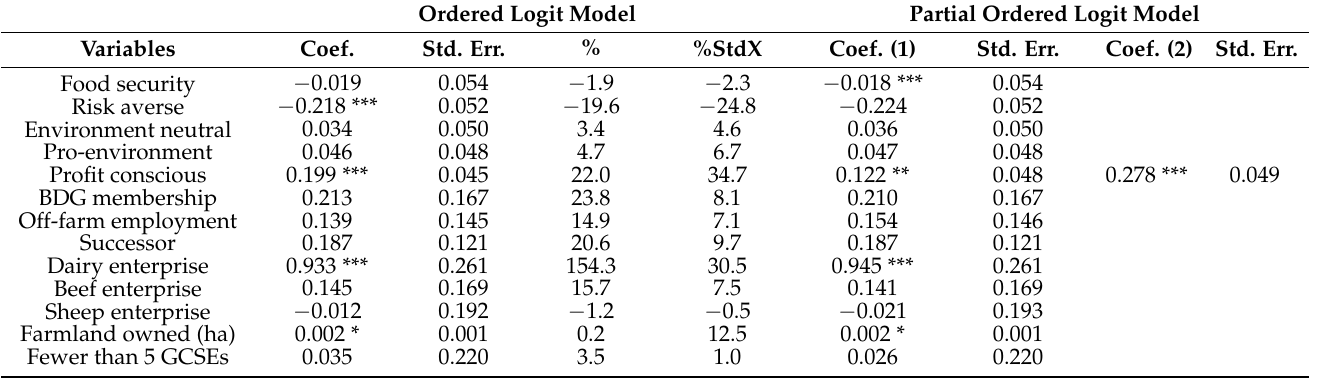
Table 3. Estimates of determinants of intention to adopt long-term land leasing without tax incentives (N =